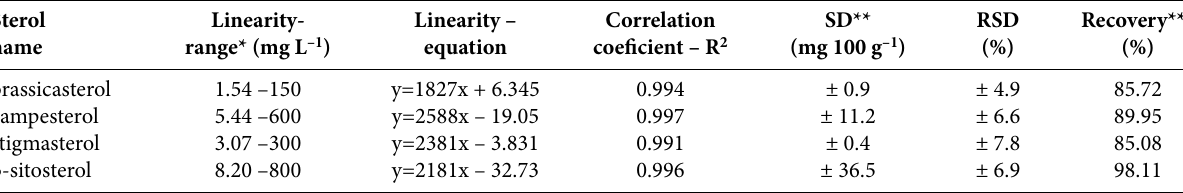
Table 2 . Results of the method validation